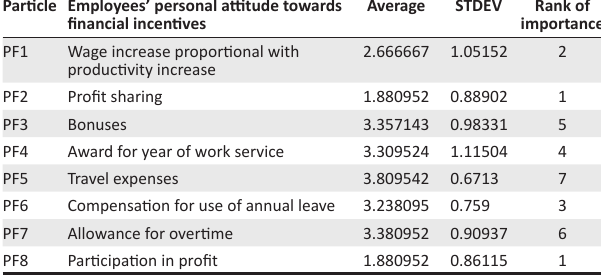
Table 6: Presence of financial incentives in the research enterprise.